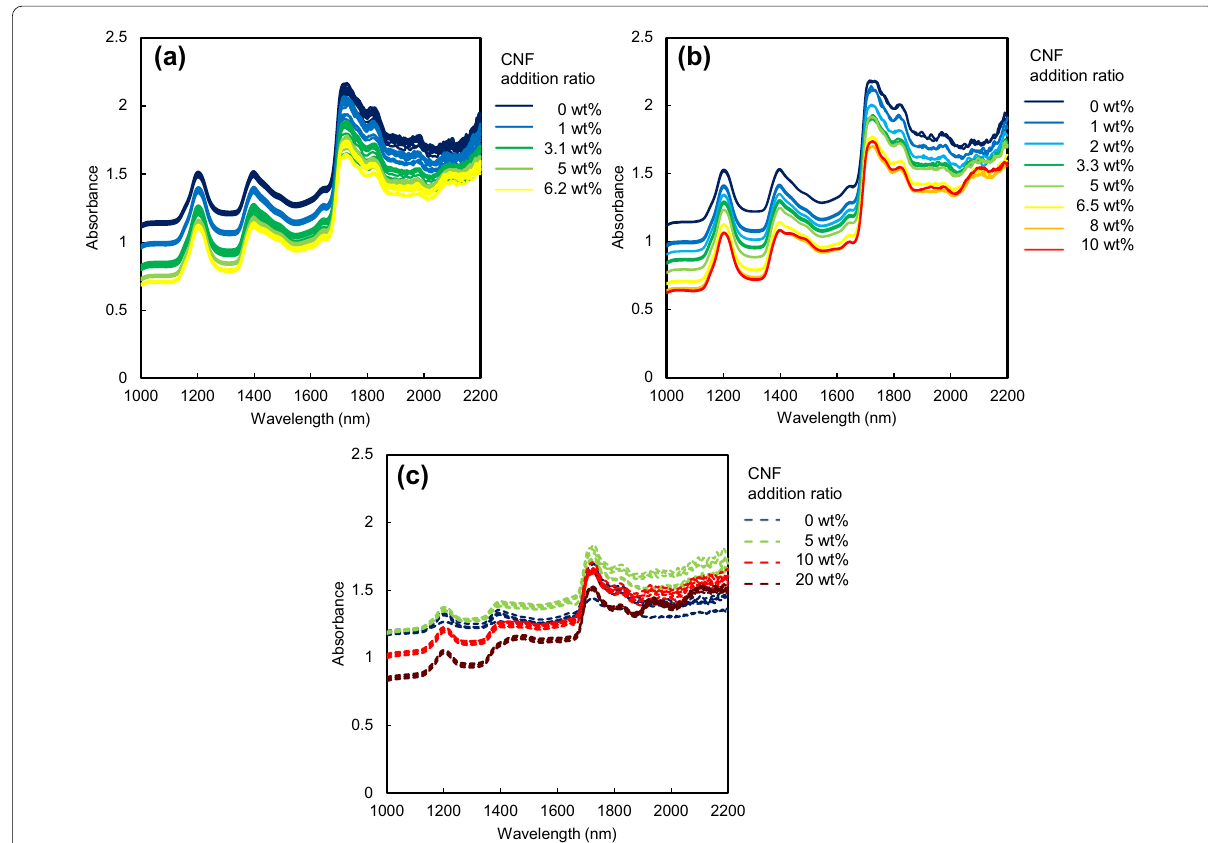
Fig. 1 The raw near infrared (NIR) spectra of each calibration set of CNF/polypropylene (PP) composites: a Injection-A, b Injection-B, c Film-A. The details of sample conditions are shown in Table